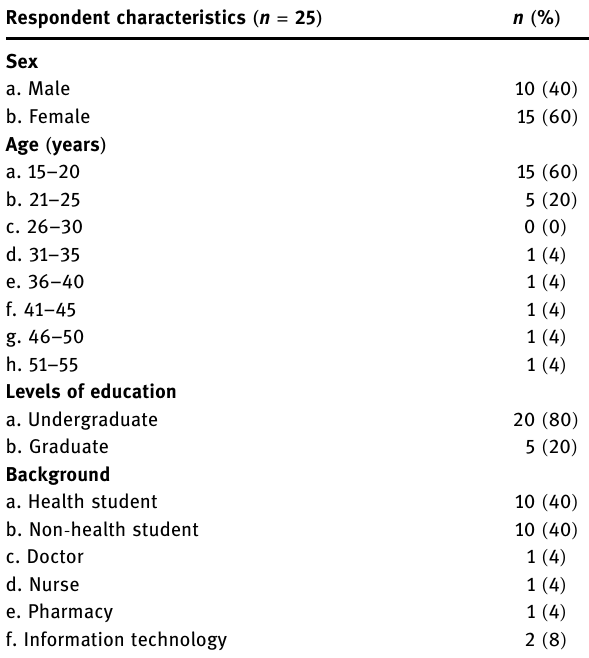
Respondent characteristics ( n = 25